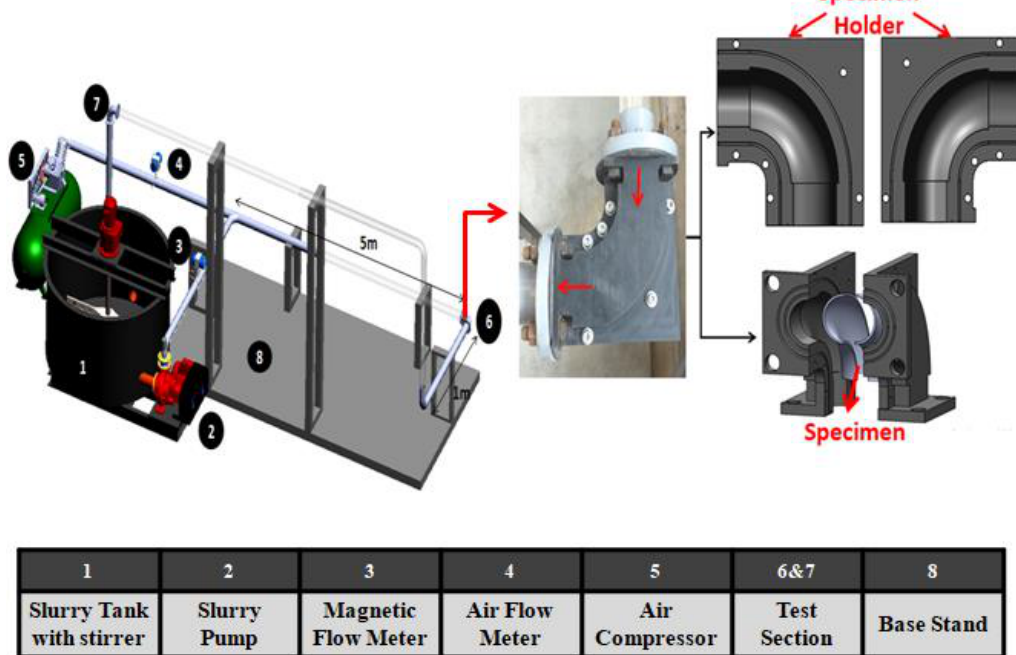
Figure 3. Experimental setup used for the present investigation.